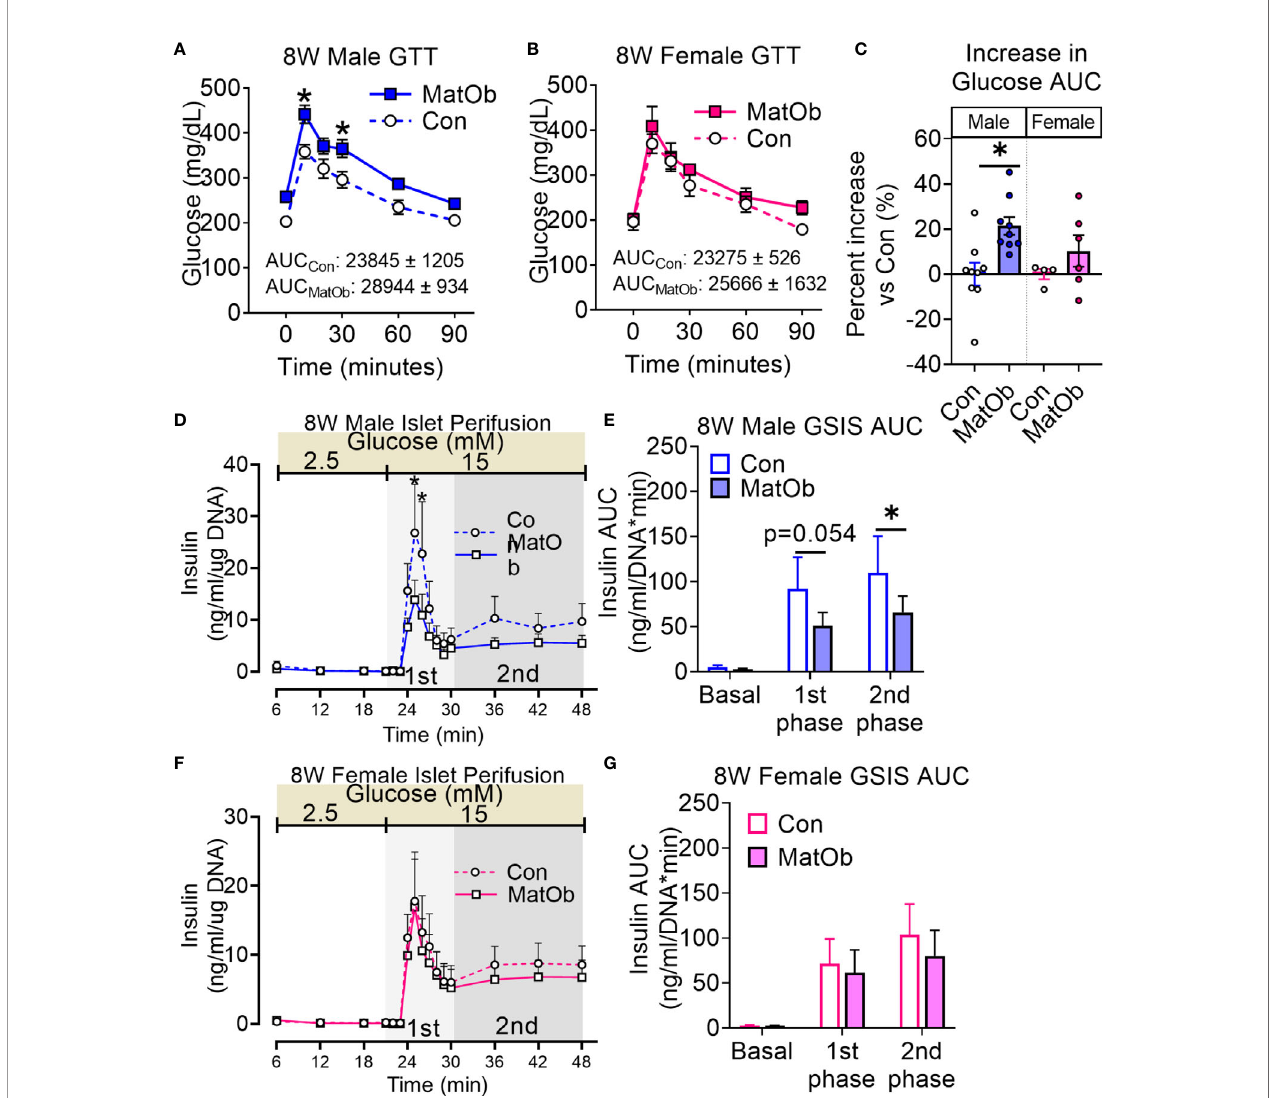
FIGURE 5 | 8W MatOb offspring continued to exhibit sex-speci fi c difference in glucose intolerance and islet insulin secretion. (A) 8W male GTT (n=9/group), (B) 8W female GTT (n=4-6/group), (C) Percent increase in GTT glucose AUC normalized to sex-matched controls. Islet perifusion studies showing (D, E) persistently decreased glucose-induced insulin secretion in 8W MatOb male offspring (n=4/group), and (F, G) unchanged glucose-induced insulin secretion in 8W MatOb female offspring (n=4/group). Experimental animals originated from at least 4 separate litters, *p <